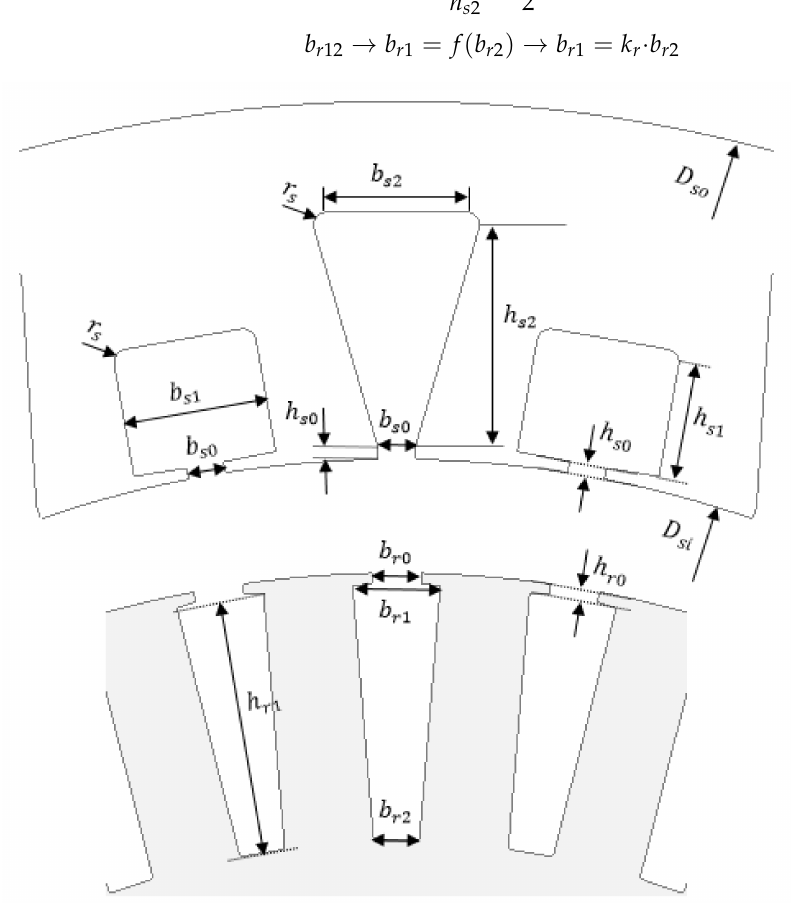
Figure 35. Stator slot and rotor geometry